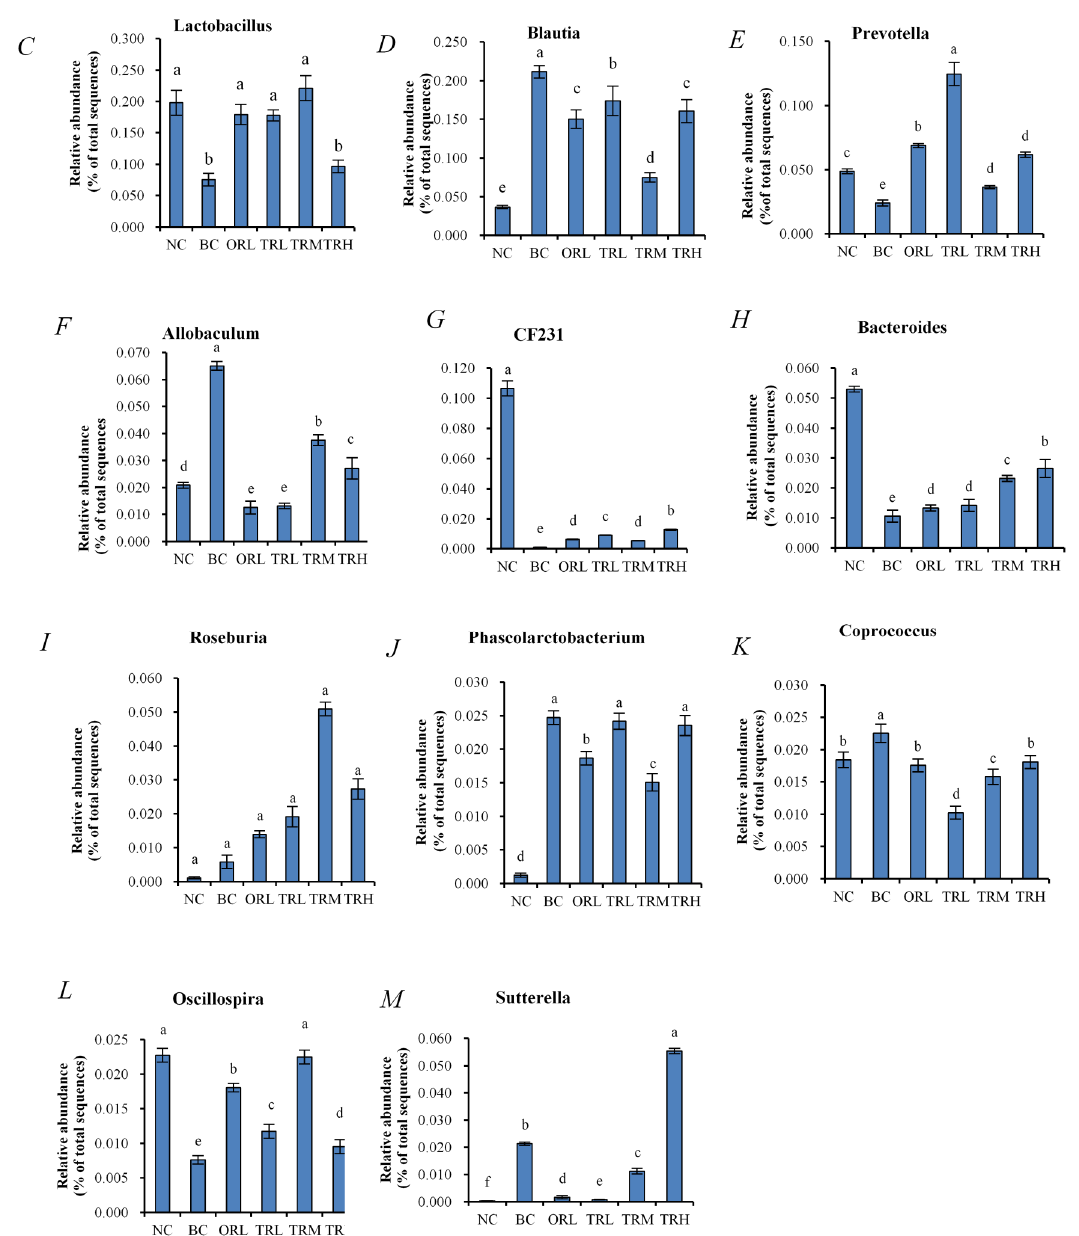
Figure 3. Microbiota compositions in BC, NC, ORL, TRL, TRM, and TRH groups. ( A ) Microbiota at the phylum level; ( B ) microbiota at the genus level; ( C – M ) relative abundances of microbiota at genus level. Different letters indicate significant differences between groups ( p < 0.05). Differences between groups were assessed by Dunnett post hoc test after a significant one-way ANOVA ( p < 0.05). NC: Normal control group, chow diet; BC: Blank control group, high-fat diet; ORL: Positive control group, orlistat; TRL: Low-dose group, trilobatin; TRM: Middle-dose group, trilobatin; TRH: High-dose group, trilobatin.